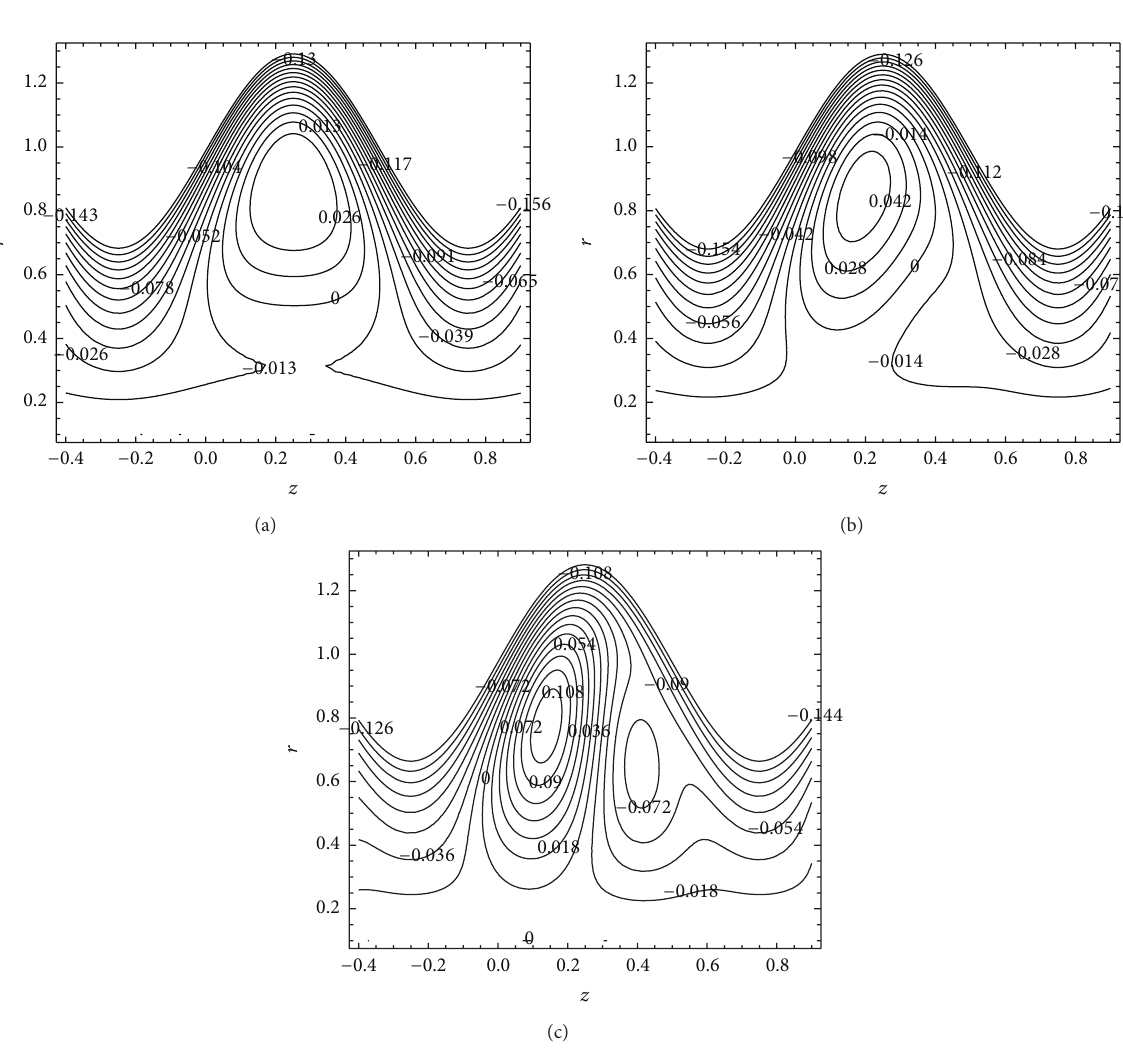
Figure 17: The effect of Reynolds number on the streamline patterns in the wave frame for different three values of Re: (a) Re = 0 , (b) Re = 10 , (c) Re = 50 at Wi = 0.02 , 𝜖 = 0.1 , 𝑄 = 0.7 , 𝛿 = 0.156 , and 𝜙 = 0.3 , 𝑟 ∈ [𝜖, 𝑟 2 ]